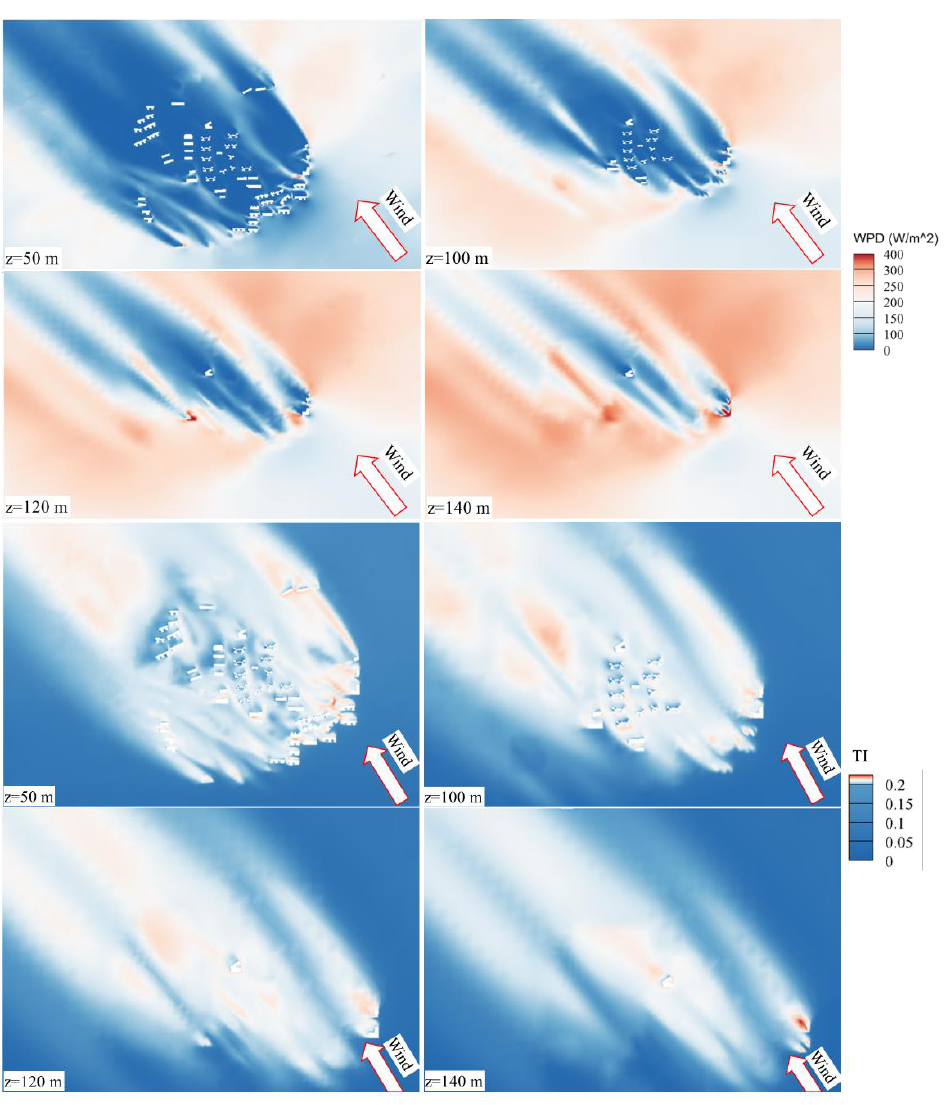
Figure 9. Contours of WPD and TI at various heights in the x - y